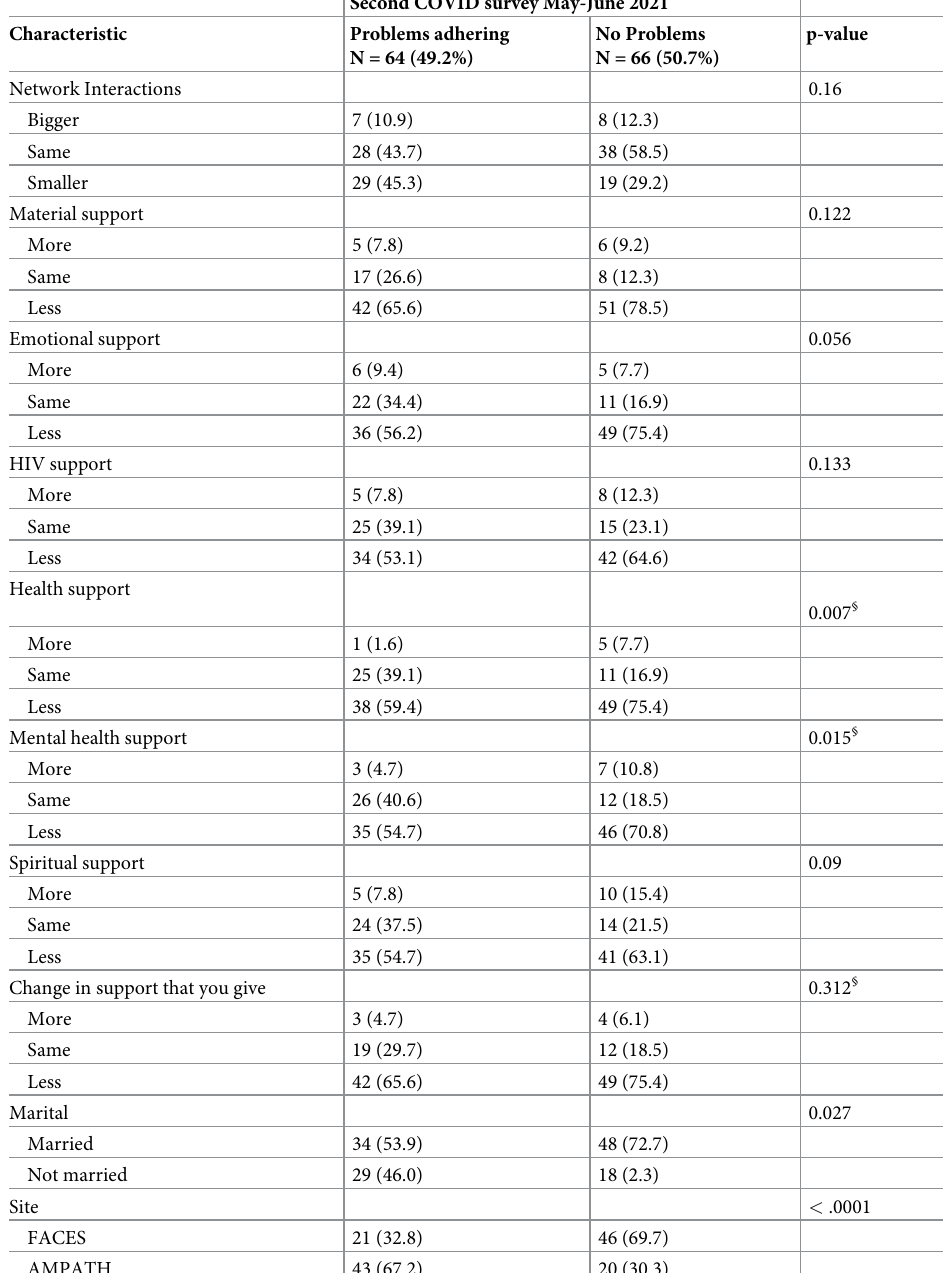
Table 6. COVID-19 survey: Social support and other factors associated with ARV �